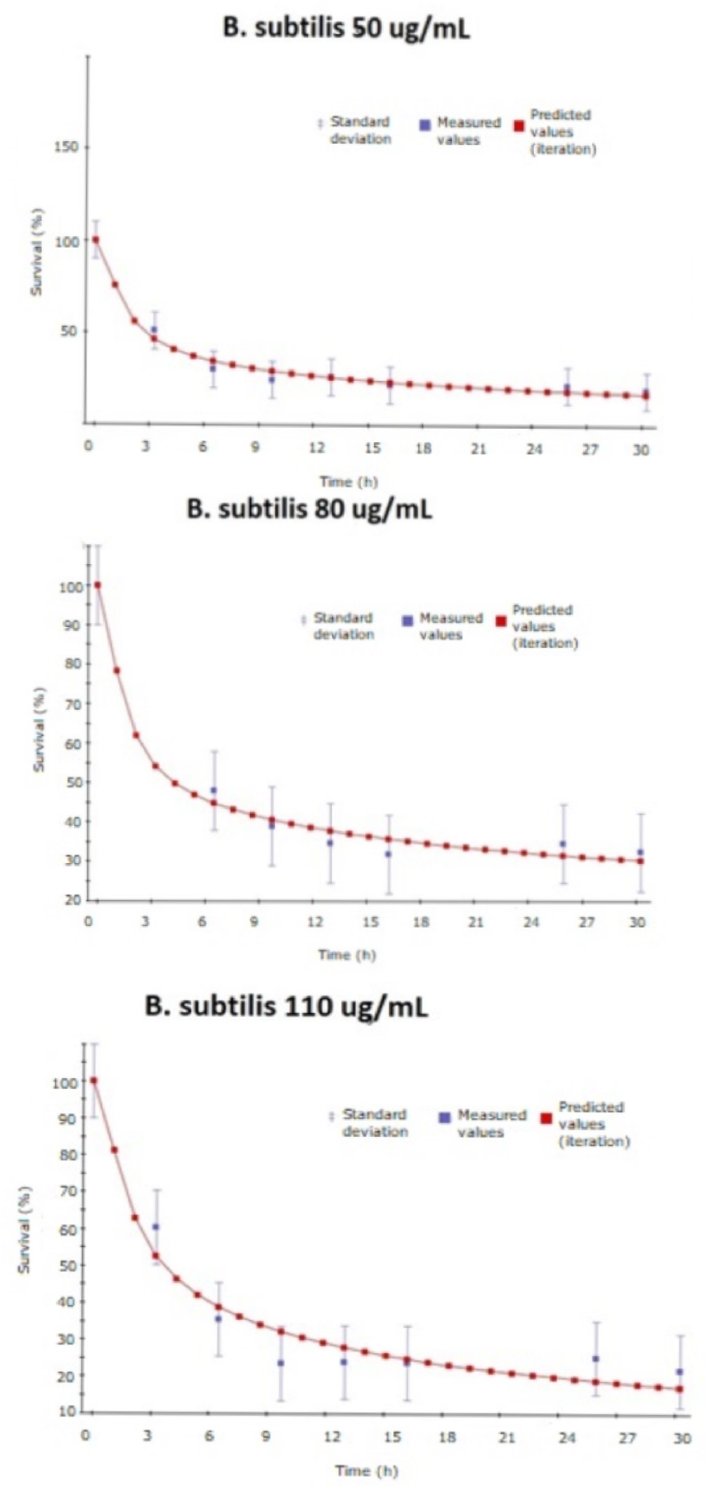
Figure 6. Experimental data and model prediction fitting for B. subtilis